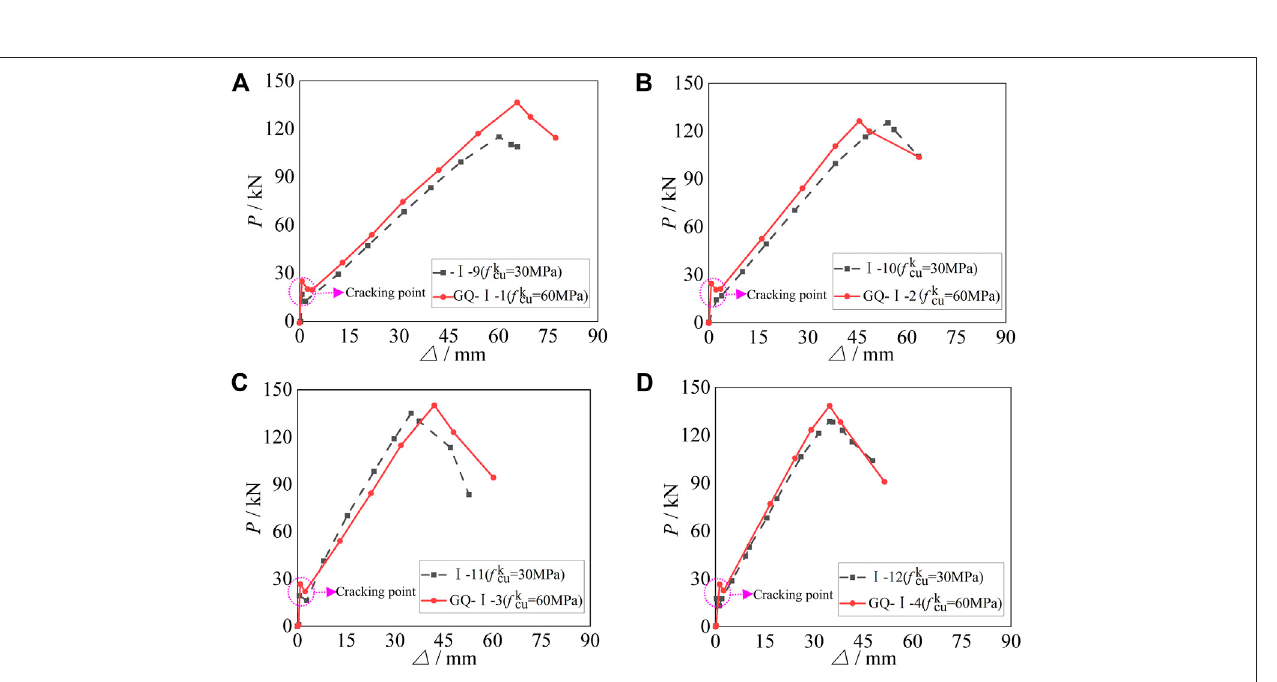
Frontiers in Materials |